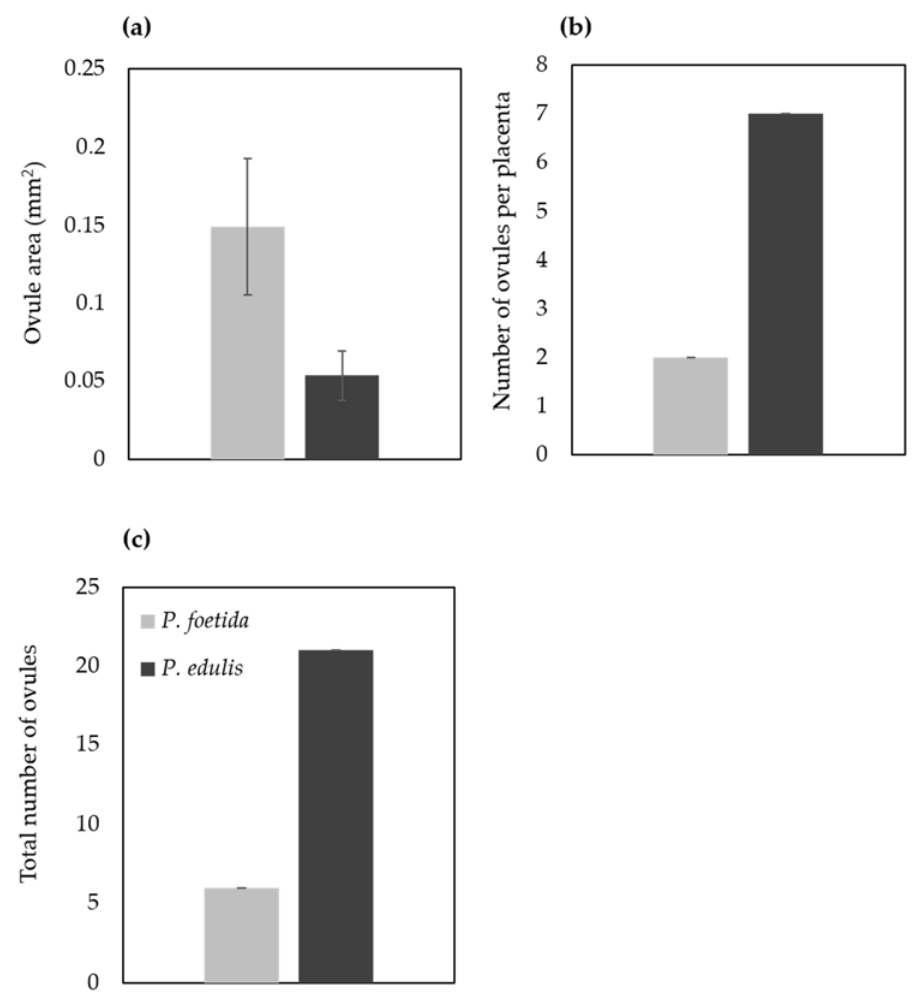
Figure 9. Size and number of ovules from P. foetida (wild) and P. edulis (cultivated). ( a ) Size, ( b ) Number of ovules per placenta and ( c ) Total number of ovules. Data are mean ± SE ( n = 6).